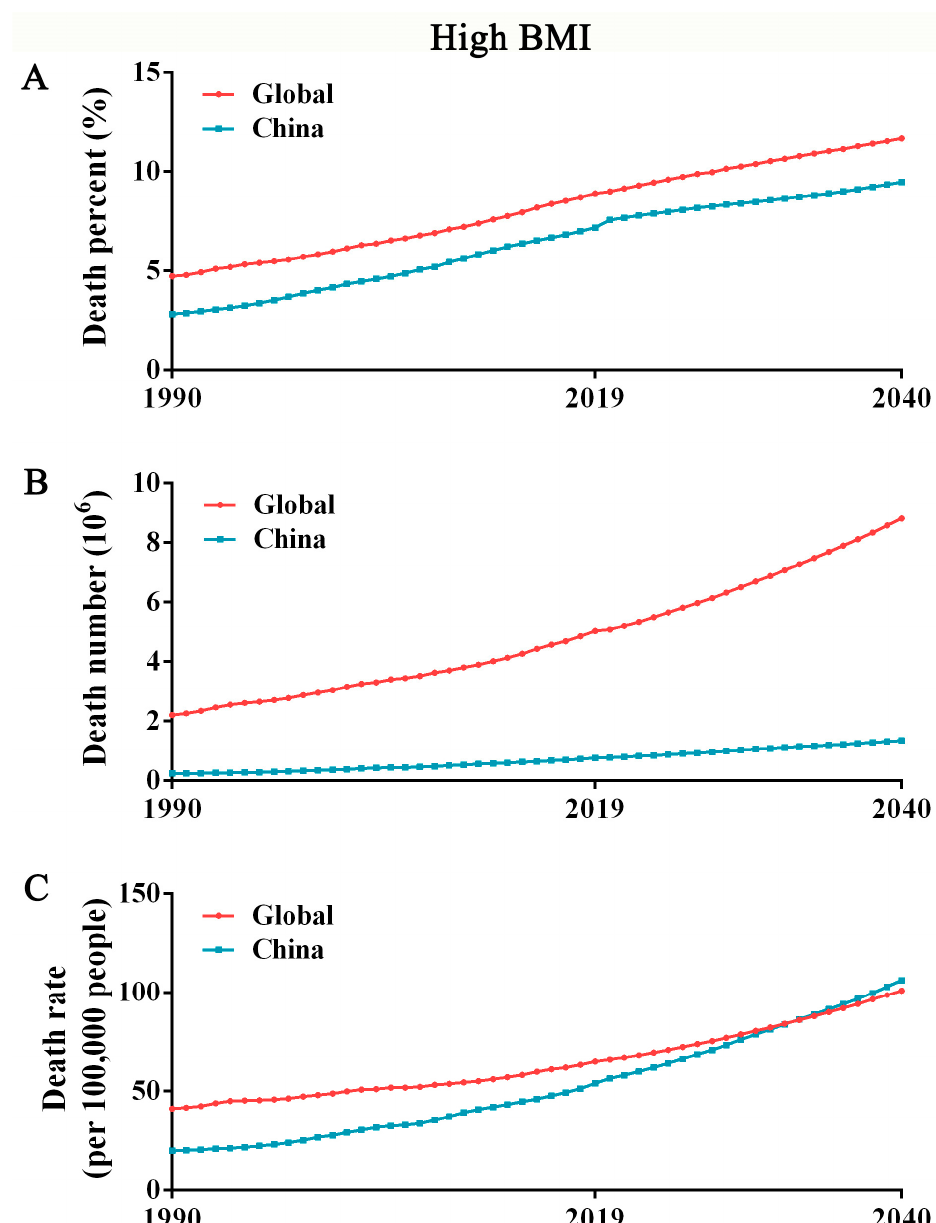
Figure 1. Death trends of high BMI globally and in China from 1990 to 2040. ( A ) Death percentage attributed to high BMI globally and in China from 1990 to 2040. ( B ) Death numbers attributed to high BMI globally and in China from 1990 to 2040. ( C ) Death rate attributed to high BMI globally and in China from 1990 to 2040.